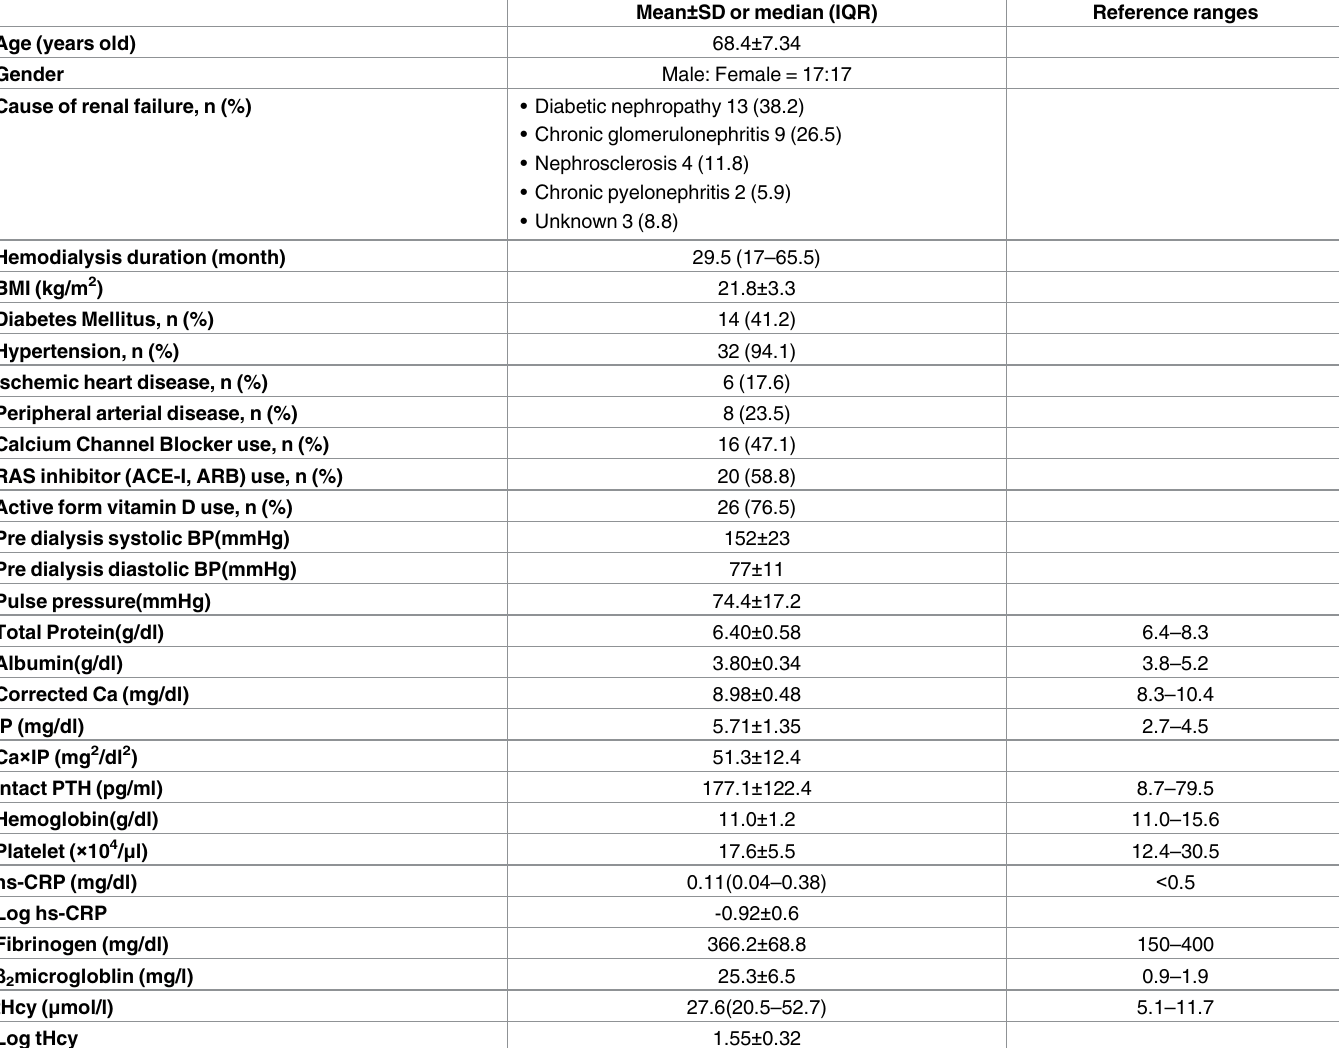
Table 1. Baseline characteristics of the